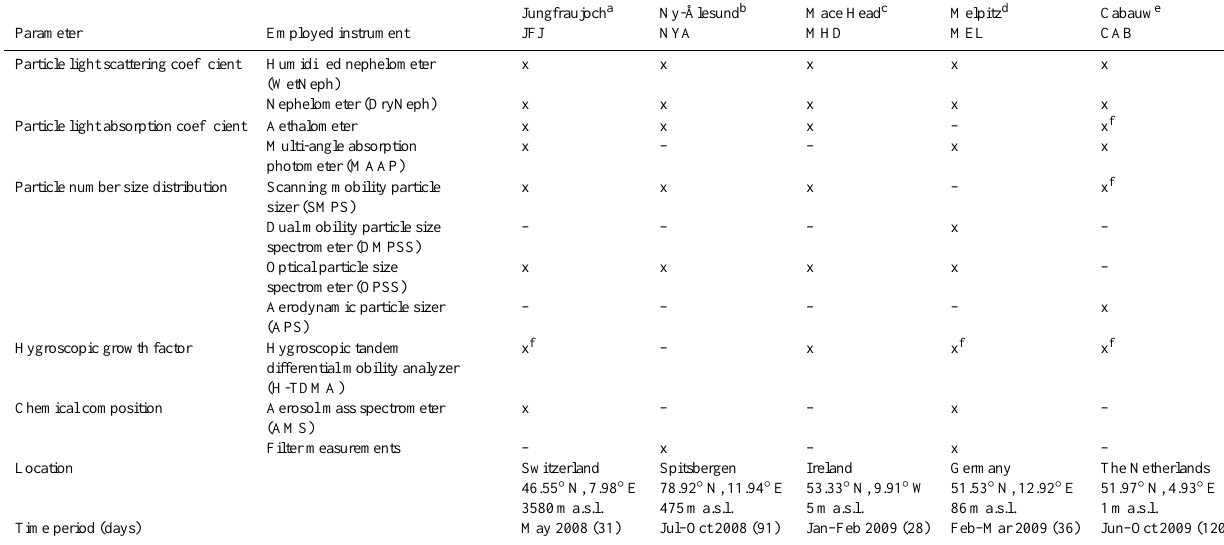
Table 1. Overview of the instrumentation used at the investigated